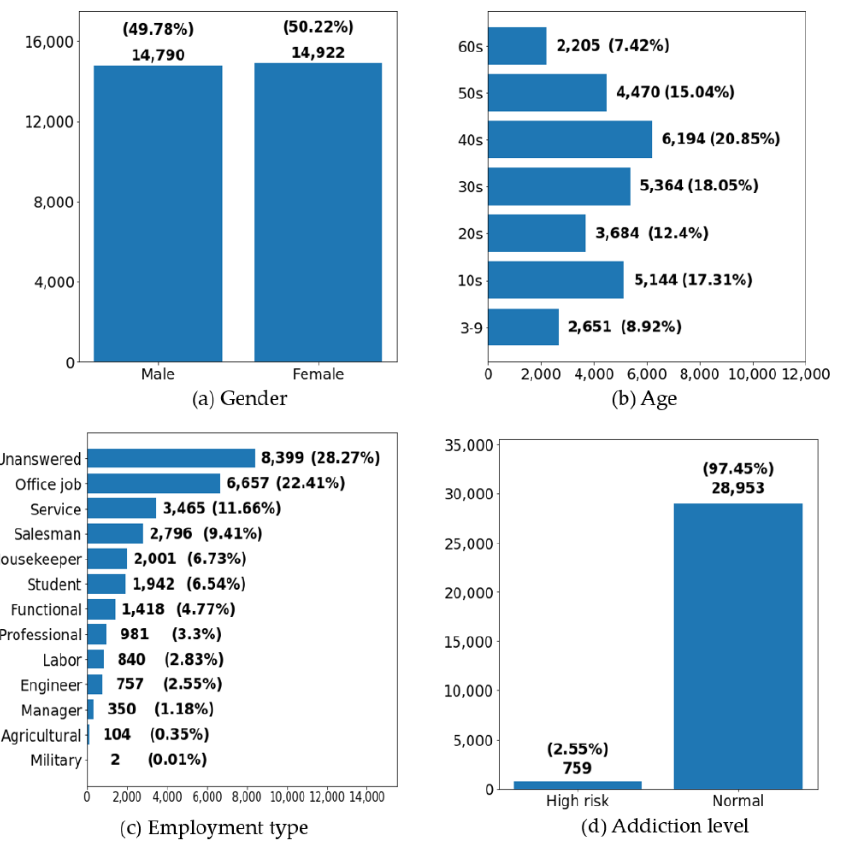
Figure 2. Users’ General Characteristics. Table 4. Smartphone Usage Level for Each Usage